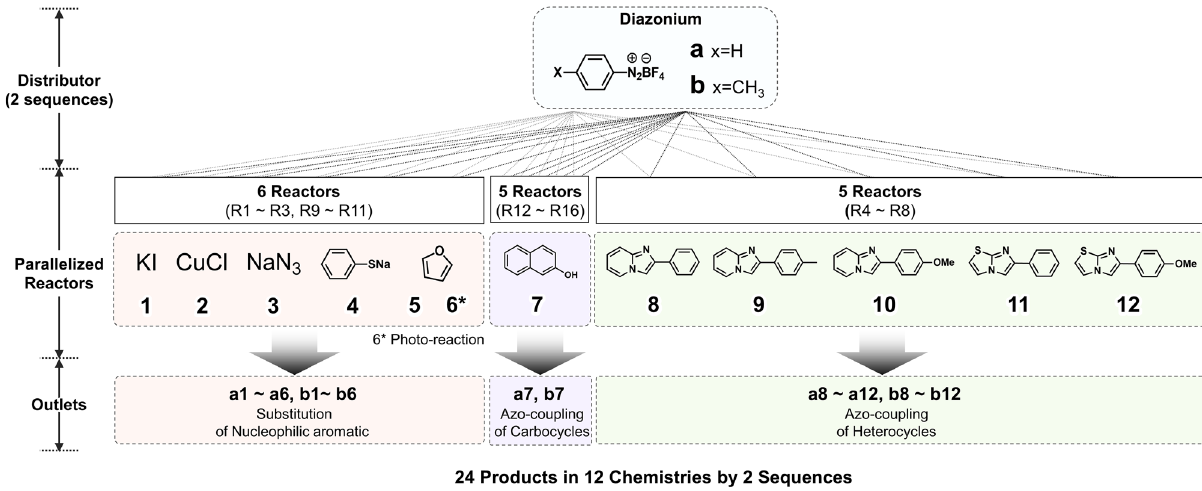
Fig. 4 Schematic of aryl diazonium chemistries enabled by multiplex reactions of fl ow parallel synthesizer via 2 sequences of experiments. A list of 12 building blocks are reacting with two types of diazonium salts to form six types of chemical bonds (two C-Halogen, C – N, C – S, C – C, – N = N – ) in a library of 24